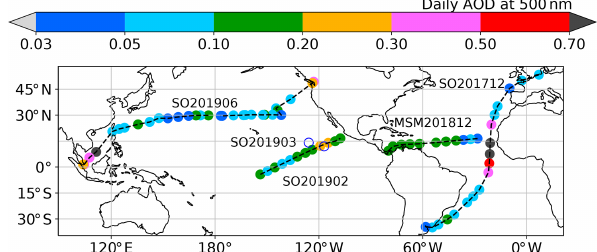
Figure 1. Daily aerosol optical thickness at 500nm (AOT) along the cruise routes. The two open circles indicate the stationary positions of RV Sonne for the cruise in March 2019 (SO201903) with no Microtops